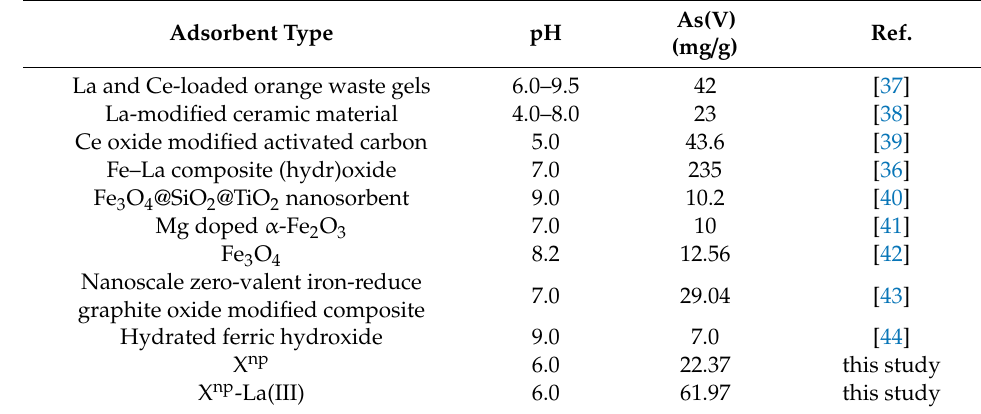
Table 7. The comparison of other sorbents used for arsenic(V) removal.